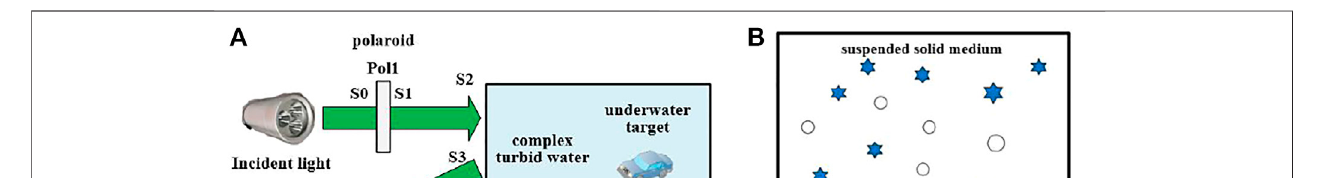
Frontiers in Physics |